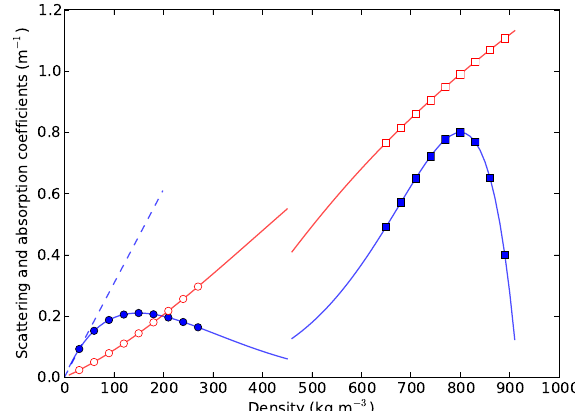
Fig. 7. Scattering (blue and plain symbols) and absorption (red and hollow symbols) coefficients at 37GHz as a function of the density. The temperature is 260K and the grain radius is 0.3mm. The model “ice spheres in air” is used for densities less than half the pure ice density (458.5kgm − 3 ). For higher densities, the model “air spheres in ice” is used. Circles and squares show the domain of validity of the DMRT-ML theory for each model. The scattering coefficient under the assumption of independent “ice spheres in air” is shown as a blue dash curve.